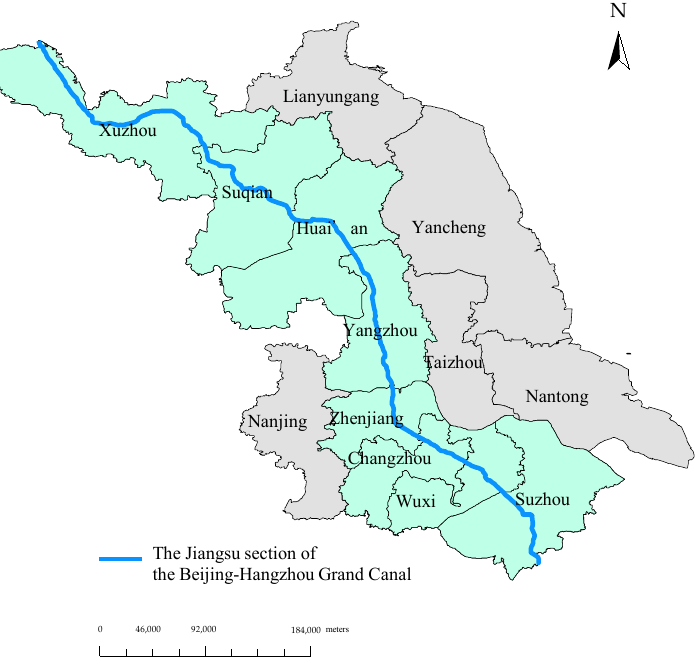
Figure 3. Drainage map of Beijing–Hangzhou Canal.